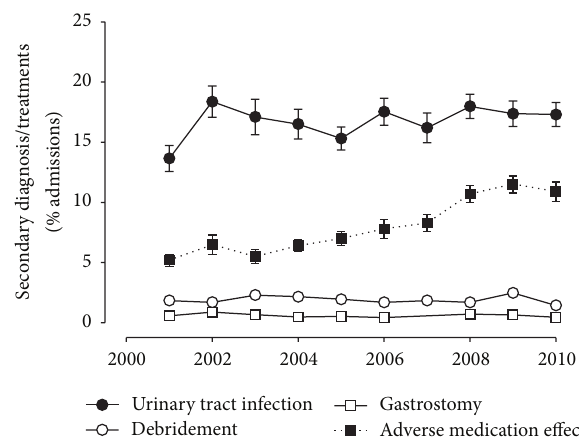
Figure 3: Time trends in surrogate measures of disease-related complications. The relative frequency of urinary tract infections (black circles) and adverse medication effects (black squares) as secondary diagnoses or wound debridement (white circles) and gastrostomy placement (white squares) were normalized for the total number of admissions and plotted as a function of